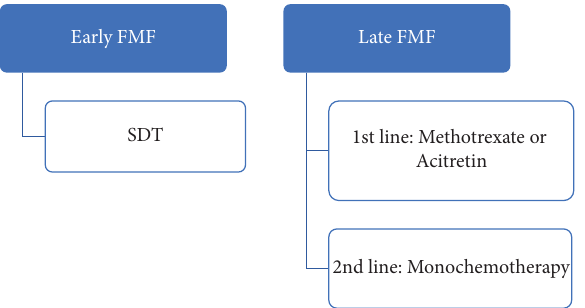
Figure 5: Algorithm for the treatment for FMF. FMF: follicular mycosis fungoides; SDT: skin-directed therapy.